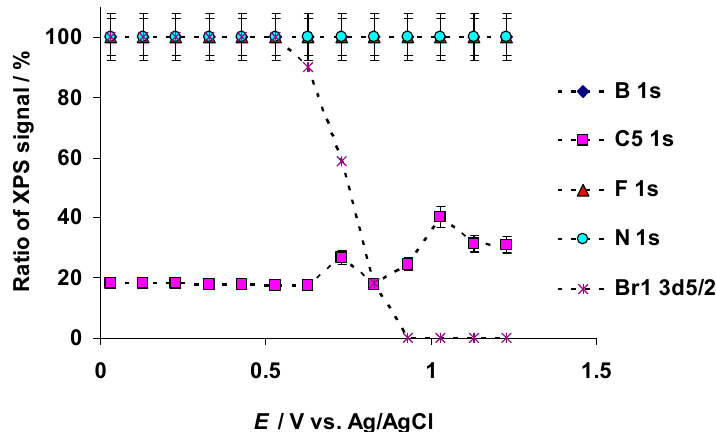
Figure 11. Dependence of EMIm + “aliphatic” carbon C 1s (marked in the figure as C5), imidazolium nitrogen atoms N 1s, BF 4 − anion boron B 1s, BF 4 − anion fluorine F 1s, and Br − anion bromine Br 3d 5/2 (marked in the figure as Br1 3d5/2) photoelectron peaks ratios for the 5 wt % EMImBr solution in the EMImBF 4 mixture at various positive potentials of the C(Mo 2 C) electrode.